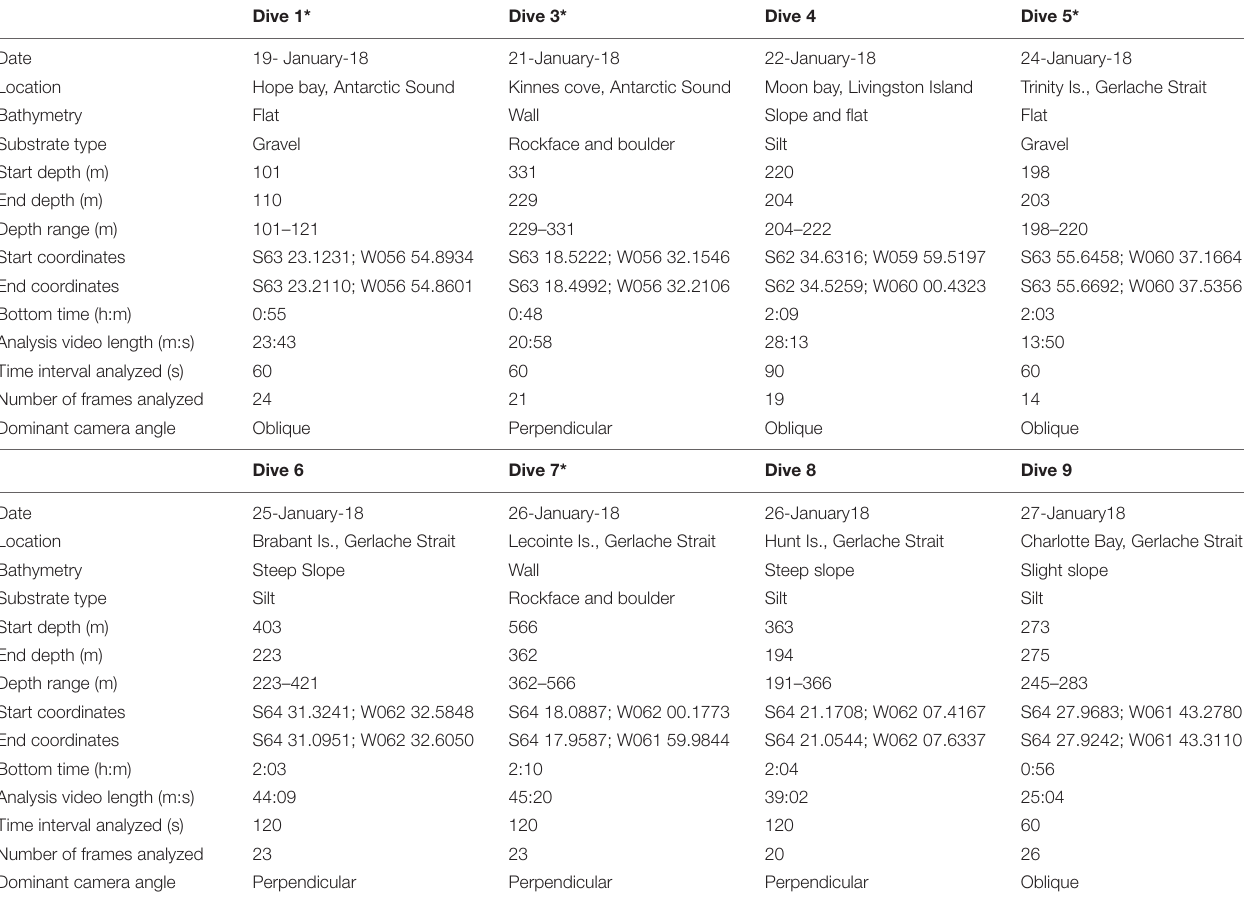
TABLE 1 | Details of the eight successful submarine dives along the western Antarctic Peninsula and Antarctic